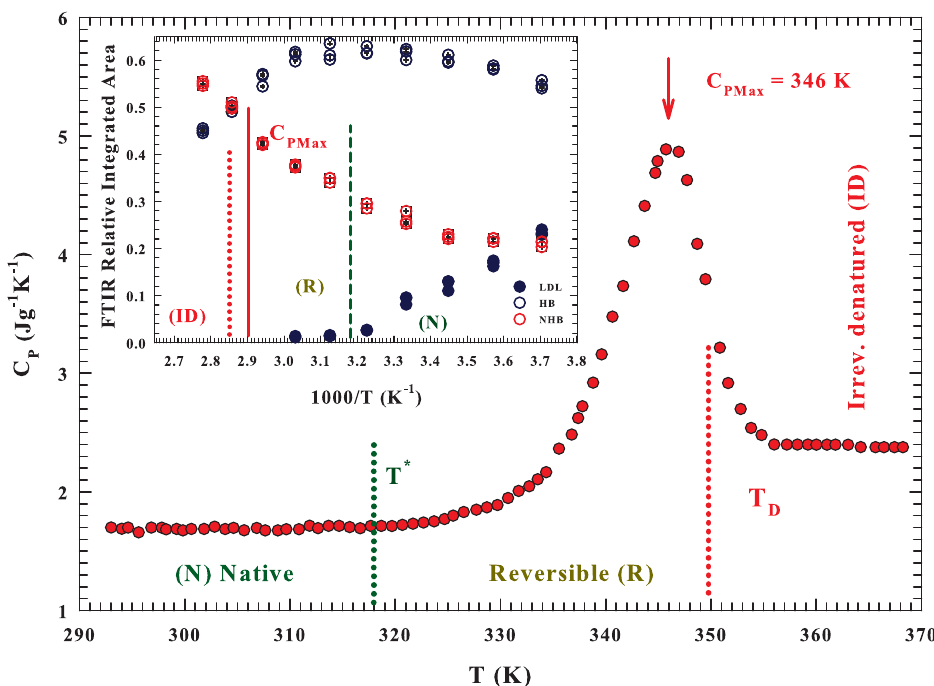
Figure 2. The measured specific heat evolution, as a function of T , in the thermal range 290 < T < 370 K, for the water/lysozyme system originally obtained in the study of the unfolding process [28]. The inset gives, in an Arrhenius plot (range 270 < T < 357 K) the FTIR OHS vibrational contributions of the hydrated lysozyme ( h = 0.3,0.37 and 0.48). In particular, the contributions of hydrogen